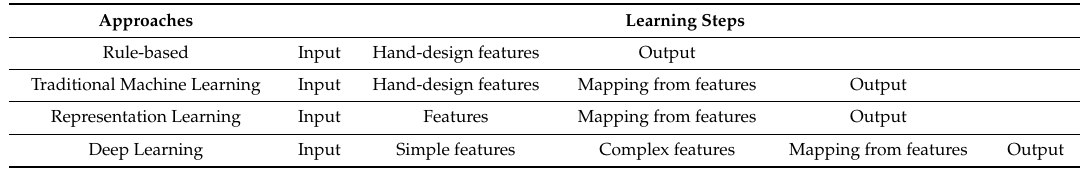
Table 1. Different feature learning approaches.